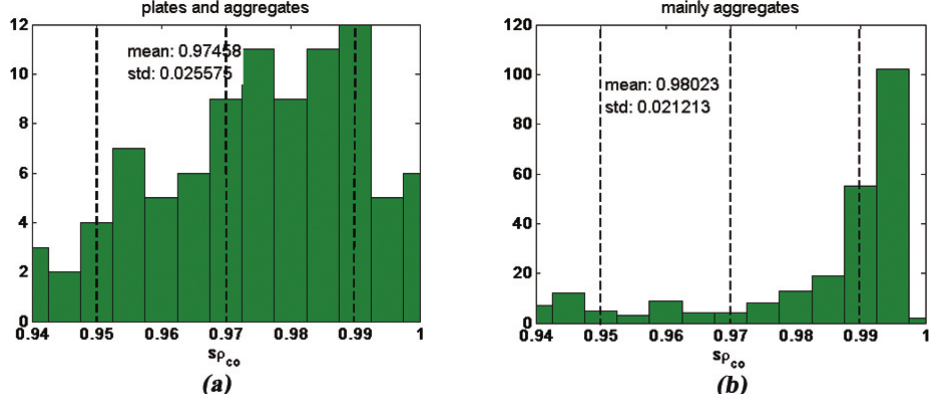
Fig. 9. Typical histograms obtained from spectral cross-correlation coefficients derived from TARA (a) when pristine crystals (plates in that case) and aggregates are observed (aircraft observations) in the radar resolution volume and (b) when mostly aggregates are observed in the radar resolution